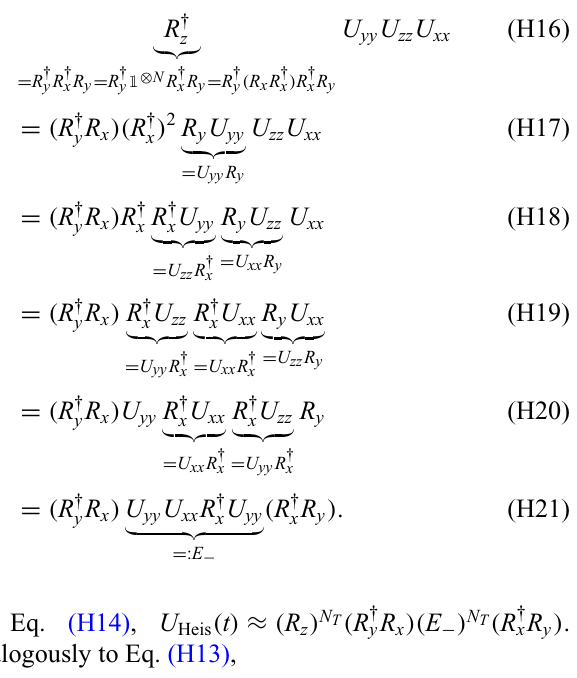
( 4 T / N ) − 1 = 300 Hz. We tot Trotter 2